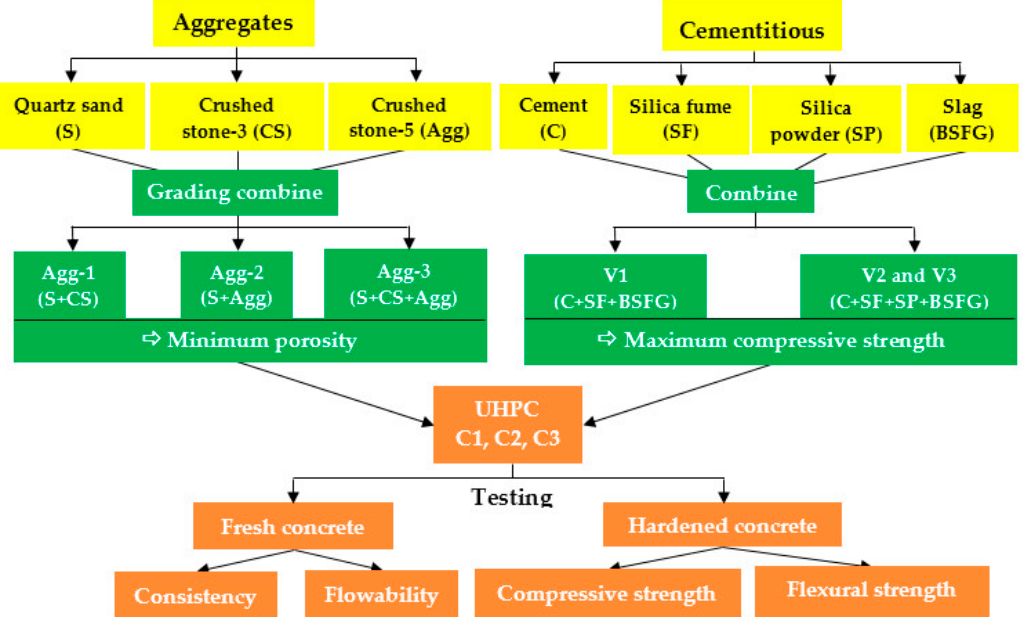
Figure 1. Steps of the experimental procedure.